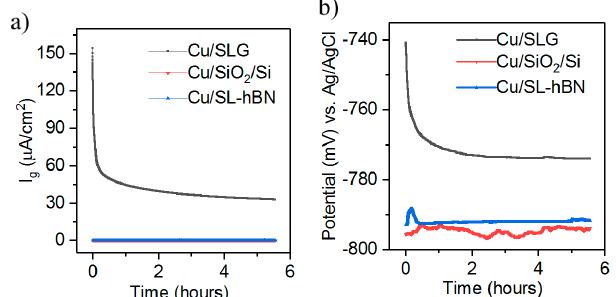
Figure 9. ( a ) Electrochemical potential sequence of various materials; ( b ) schematic diagrams for galvanic coupling of graphene and hBN-coated Cu. Graphene galvanically couples Cu and oxygen that increases corrosion, whereas, hBN shows no galvanic coupling; ( c ) pitting corrosion due to a galvanic coupling of two different metal featuring a large ratio of cathodic to the anodic area corresponding to higher corrosion current; ( d ) and ( e ) Corrosive species attacking and propagating through grain boundaries of anodic metal (exposed due to scratch) and reducing material strength rapidly. Adapted with permission from ref. [137]. Copyright 2017 Springer Nature Limited. And adapted under Creative Commons Attribution-NonCommercial 3.0 Unported Licence from ref. [70] —Published by The Royal Society of Chemistry.